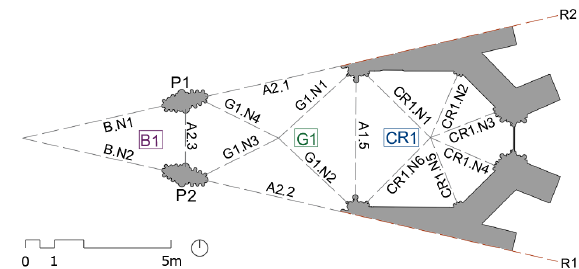
Figure 2: Nomenclature of the elements.